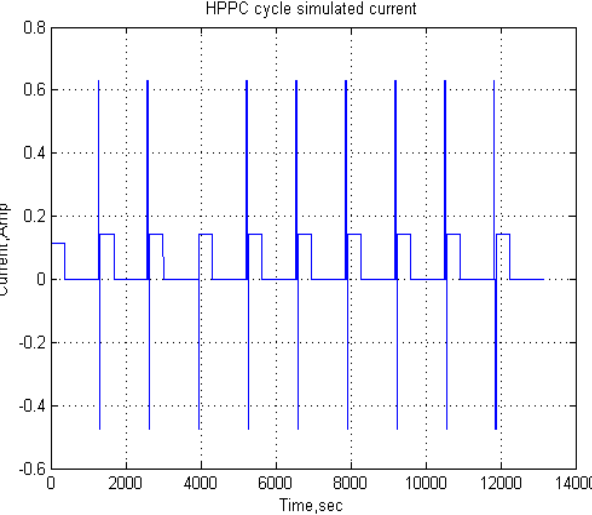
Figure 3. Hybrid Pulse Power Characterization (HPPC) cycle simulated load profile used in fault diagnosis.